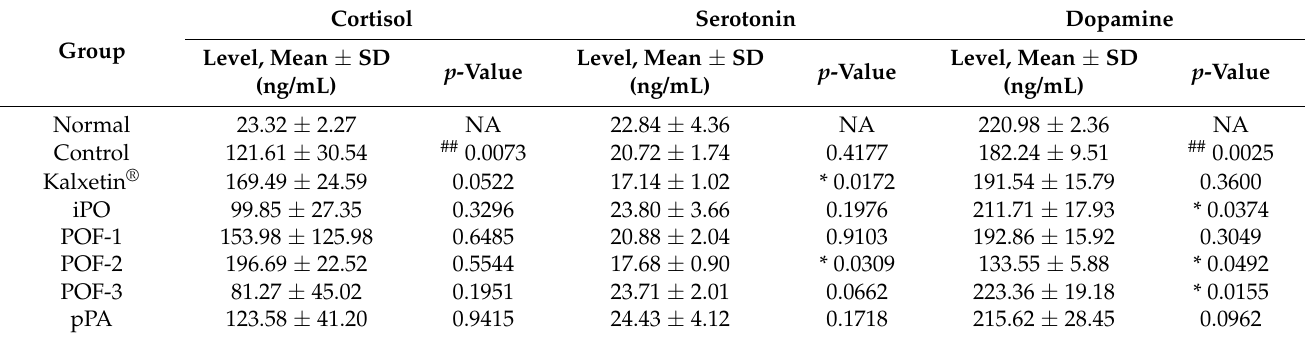
Table 2. Level of plasma cortisol and brain serotonin and dopamine (n =